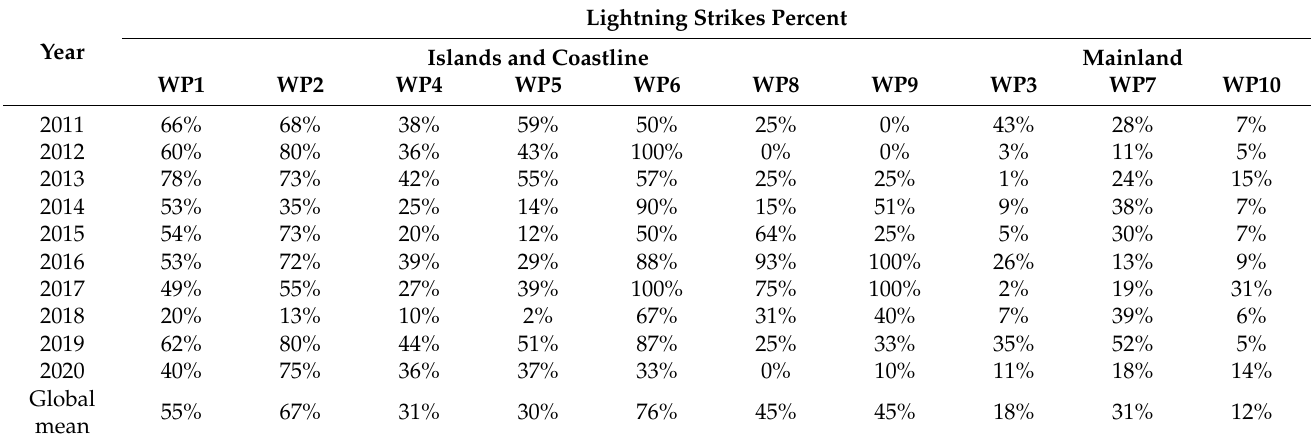
Table A2. Lightning strikes in autumn as a percentage of the total strikes per year.